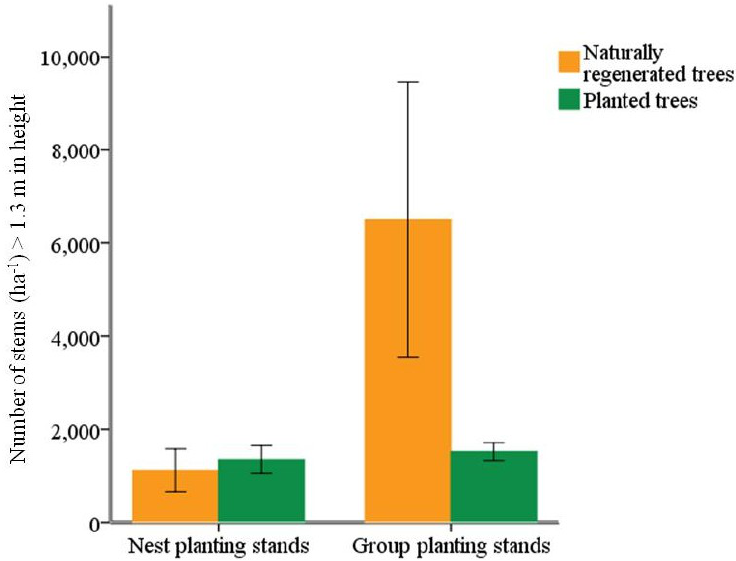
Figure 7. Density of naturally regenerated and planted trees (>1.3 m height) grown in cluster planting stands. Lines denote standard error at 95% confidence interval.